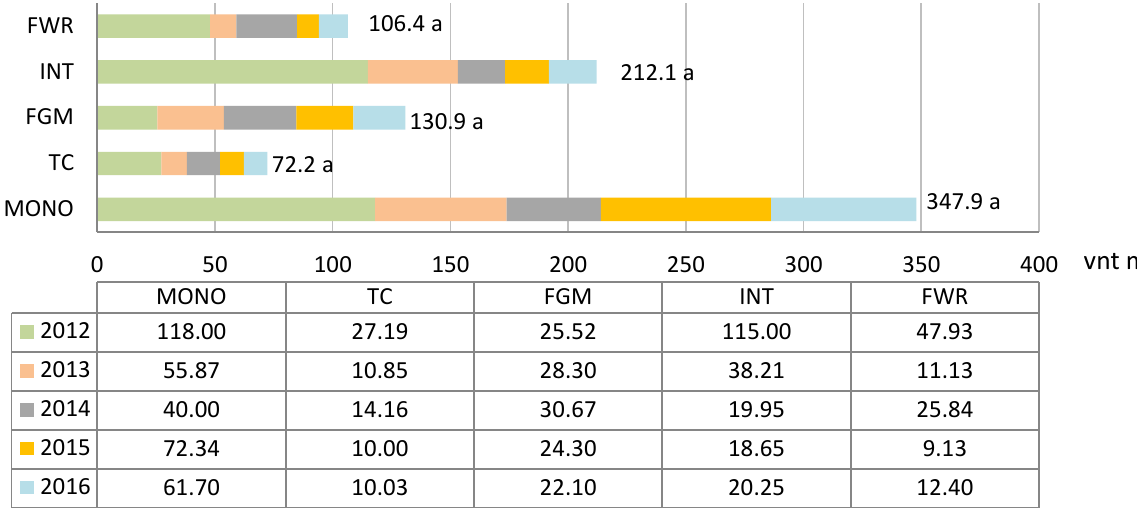
Figure 1. The amount and 5 years average of weeds seedlings per m − 2 in winter rye crops, 2012–2016. Note: different letters indicate significant differences between the treatments ( p ≥ 0.05); FWR—field rotation with row crops; INT—intensive rotation; FGM—rotation for green manure; TC—three-course rotation; MONO—rye monoculture.